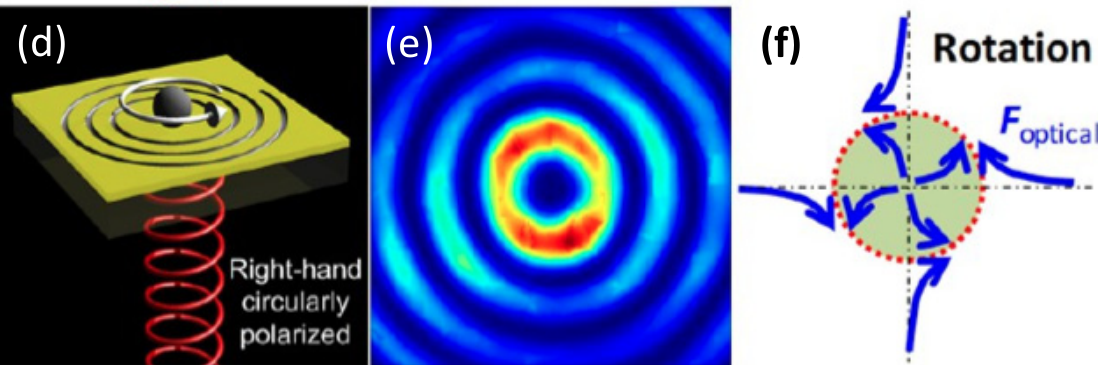
Figure 3. Plasmonics induced rotation of microparticles. ( a ) Under left-hand circularly-polarized plane wave excitation, the EM field is focusing with no angular momentum to trap the microparticles; ( b ) The intensity distribution of (a) is shown; ( c ) Schematic of the trapping force; ( d ) Under right-hand circularly-polarized plane wave excitation, the EM field imparts angular momentum to rotate the microparticles; ( e ) The intensity distribution of (d) is shown; ( f ) Schematics of the trapping forces. Reproduced with permission from [37]. Copyright 2013, American Society of